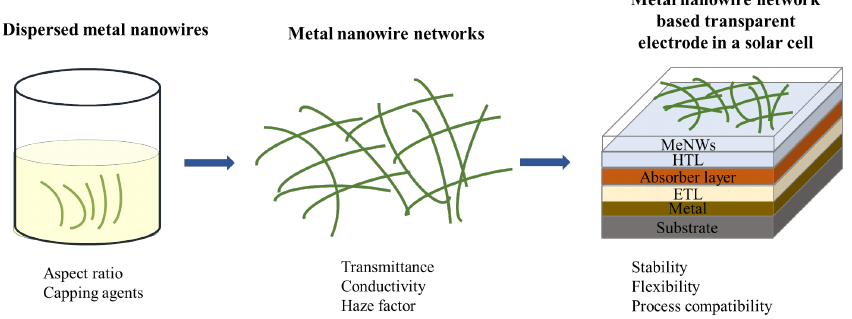
Figure 7. Schematic illustration of the design principles for metal nanowire network based transparent conductors: from the synthesis of metal nanowires, assembly of metal nanowire networks and applications in solar